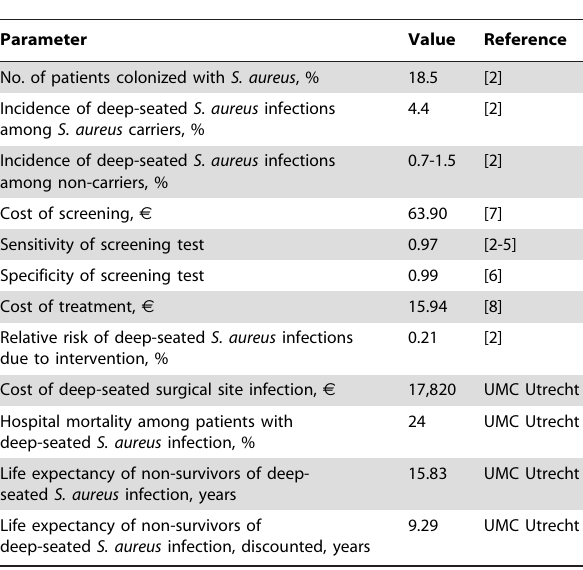
Table 3. Parameters used in cost-effectiveness analysis.